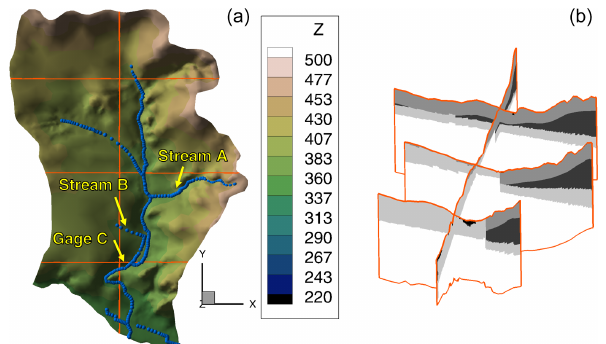
Figure 1. Illustration of the model domain. (a) Shape of the domain and topography; (b) example of a geological